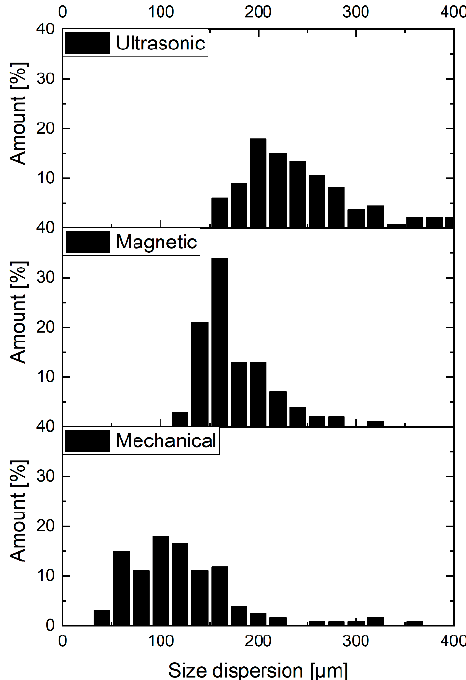
Figure 5. Particle size distribution at different stirring methods.